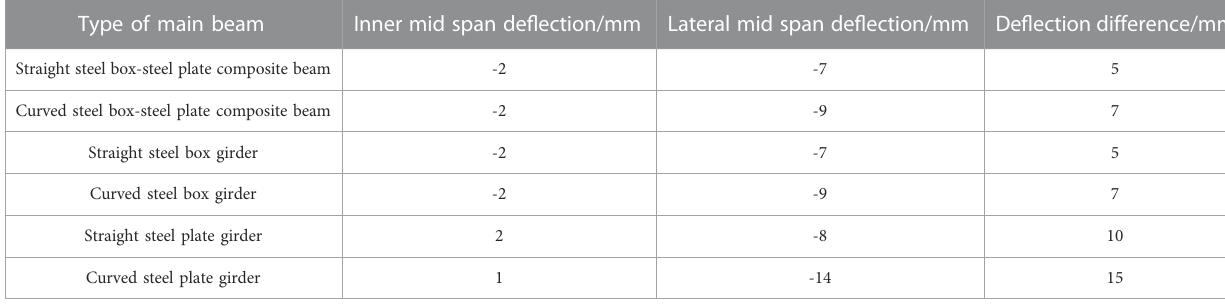
TABLE 4 De fl ection of girder under eccentric load on the outside of